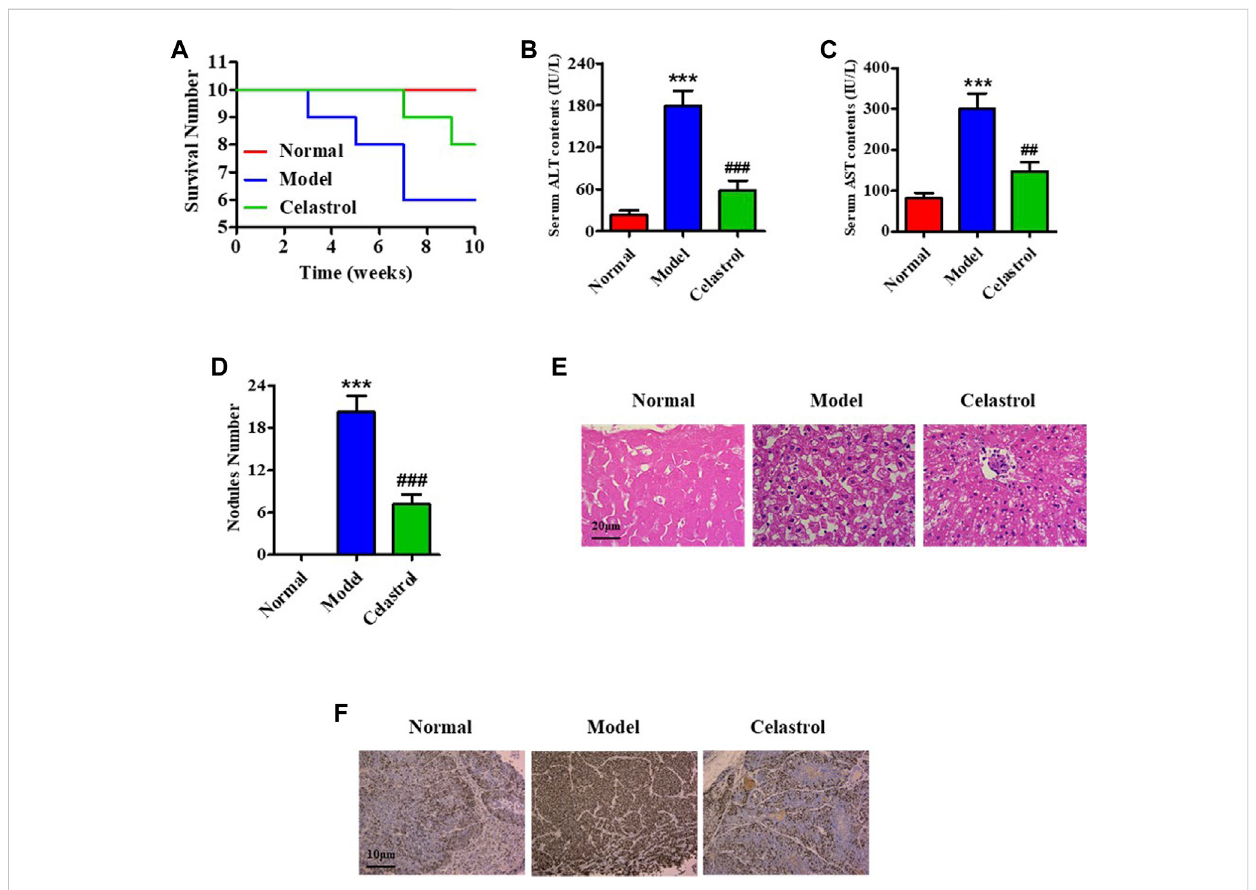
FIGURE 1 Celastrol alleviates HCC in an orthotopic rat model. (A) The survival number of rats. Serum levels of (B) ALT and (C) AST. (D) Nodule numbers of liver tissue, (E) H&Estainingforpathologyanalysis. (F) IHCforprobingki67expression.***p < 0.001vs.normalgroup; ## p < 0.01, ### p <